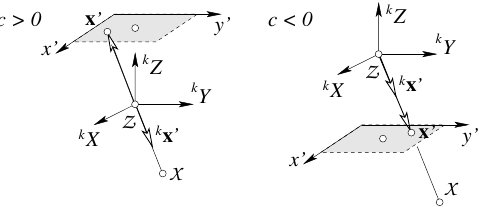
Figure 2: The direction of the homogeneous image coordinate vector and the direction of the ray is different depending on the sign of the principal distance c